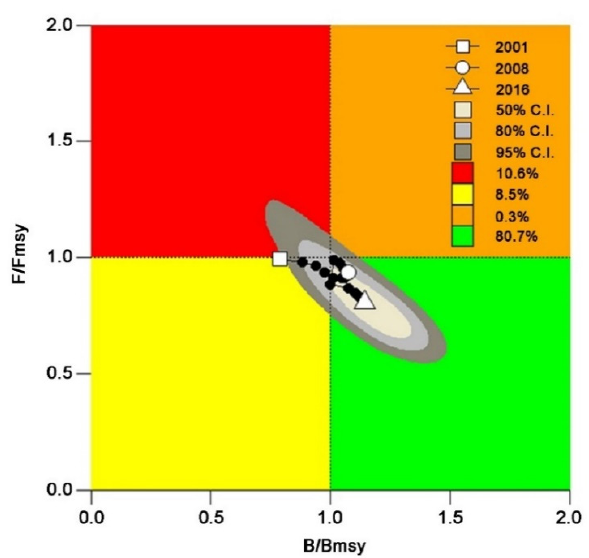
Figure 5. Kobe plot illustrating the concurrent movement of exploitation (F/F MSY ) and the relative biomass (B/B MSY ) of croaker in the BoB waters of Bangladesh.